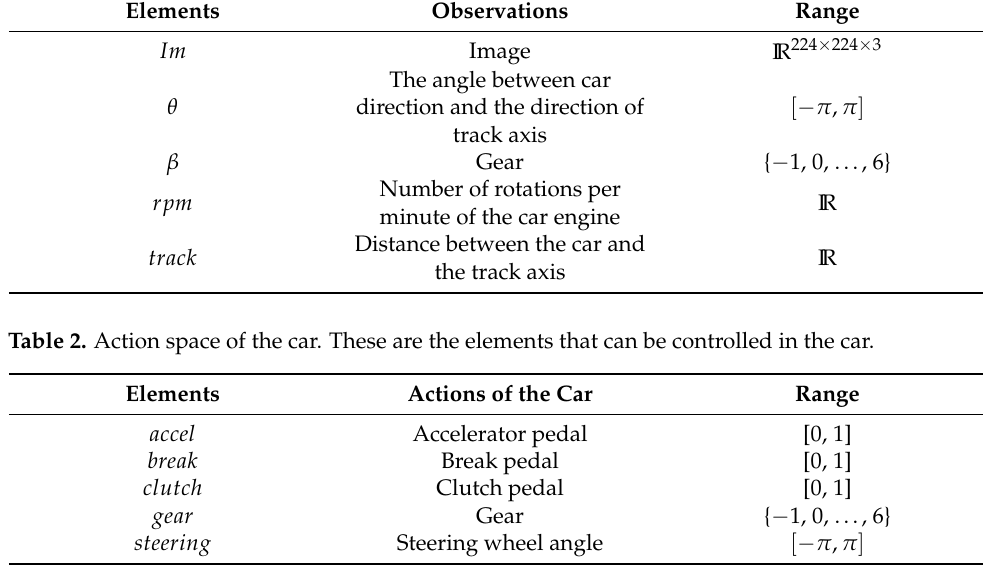
Table 1. Observation space of the car. These are the elements that can be read from the car’s sensors. Elements Observations Range